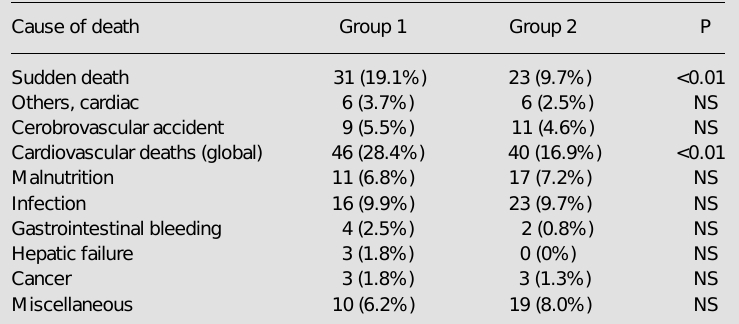
NS, Nonsignificant (chi-square